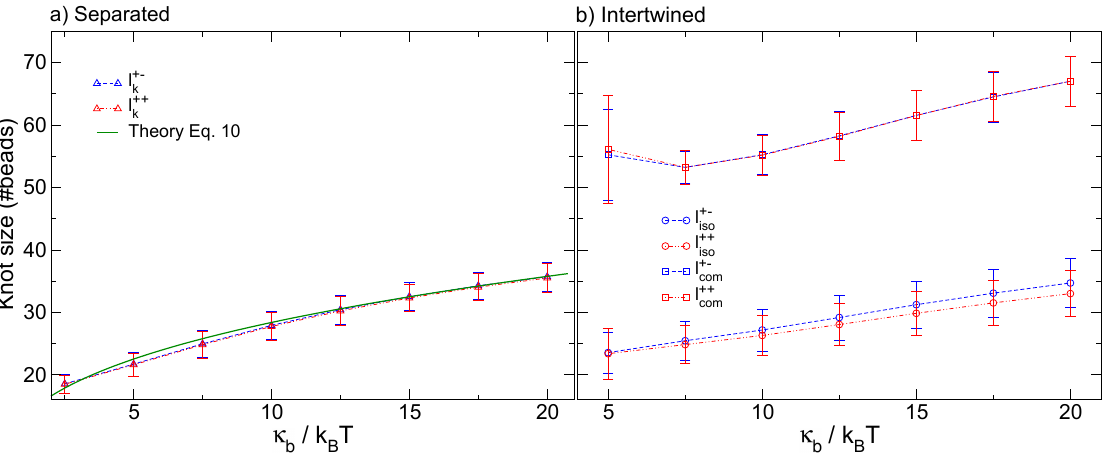
Figure 2. ( a ) Size of separated trefoil knots, plotted as a function of κ b ; ( b ) Size of a nested trefoil knot (circles) as well as of the composite knot (squares) when the two trefoils are intertwined, plotted as a function of κ b